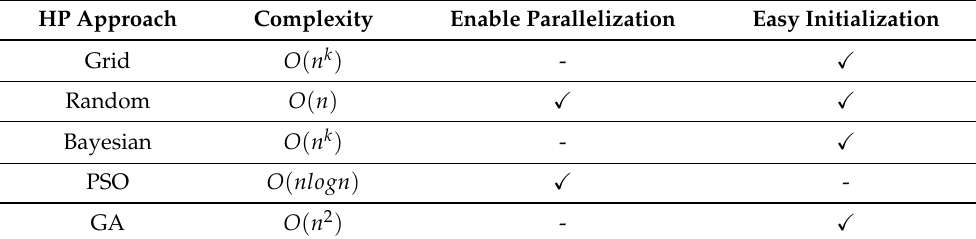
Table 1. Comparison of hyperparameter tuning algorithms (where k is the number of hyperparame- ters and n is the number of values for hyperparameters).